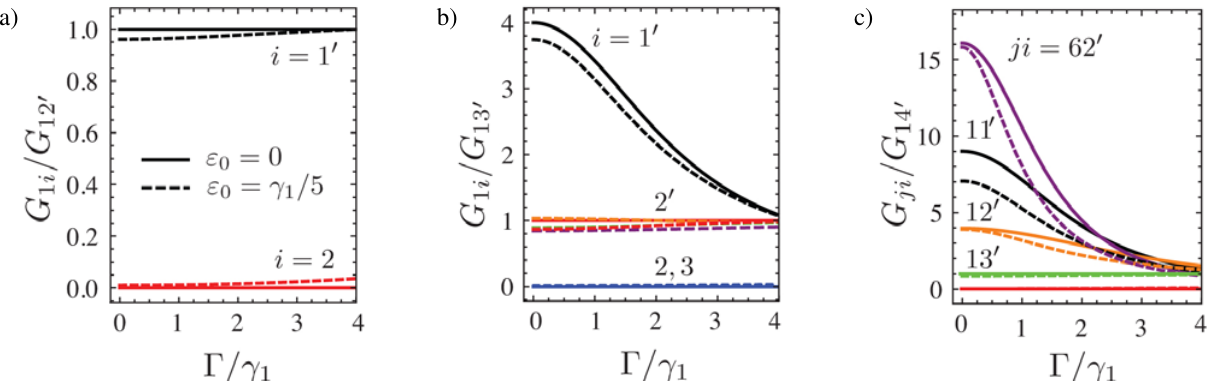
Figure 3. Magic ratios at T = 0 of the (a) benzene, (b) naphthalene, and (c) anthracene molecule at the particle-hole symmetric point (full lines) and for ε = γ /5 (dashed lines) as a function of the coupling Γ of an electrode to a molecular site. Molecular sites to which electrodes are attached are 0 1 indicated next to each curve. The other combination of electrode attachment sites appearing in the conductance ratio corresponds to the most distant sites of a particular